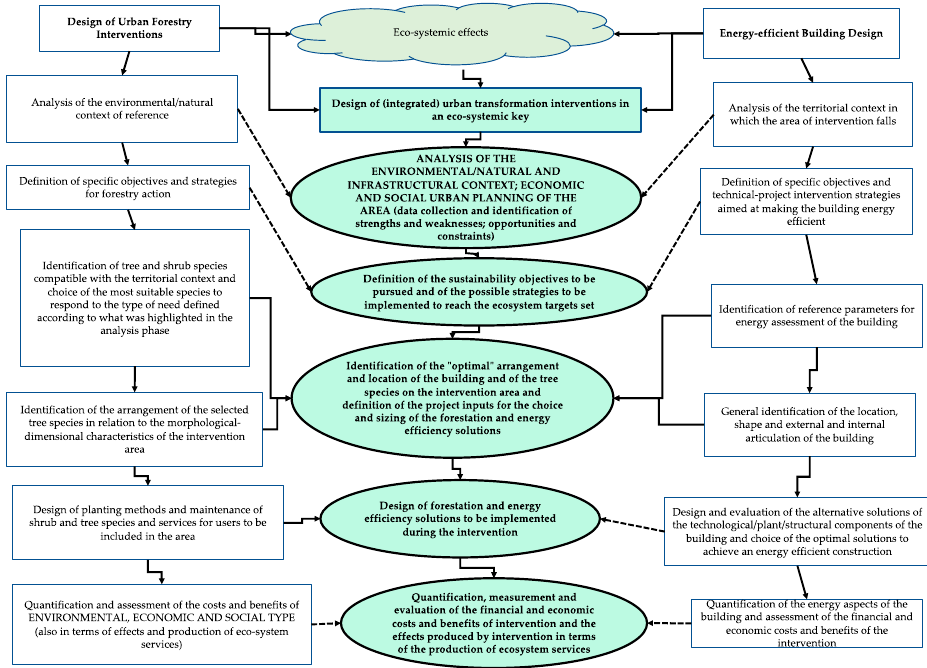
Figure 2. Evaluation methodology for settlement transformation interventions developed in an integrated key with urban forestation projects. integrated key with urban forestation